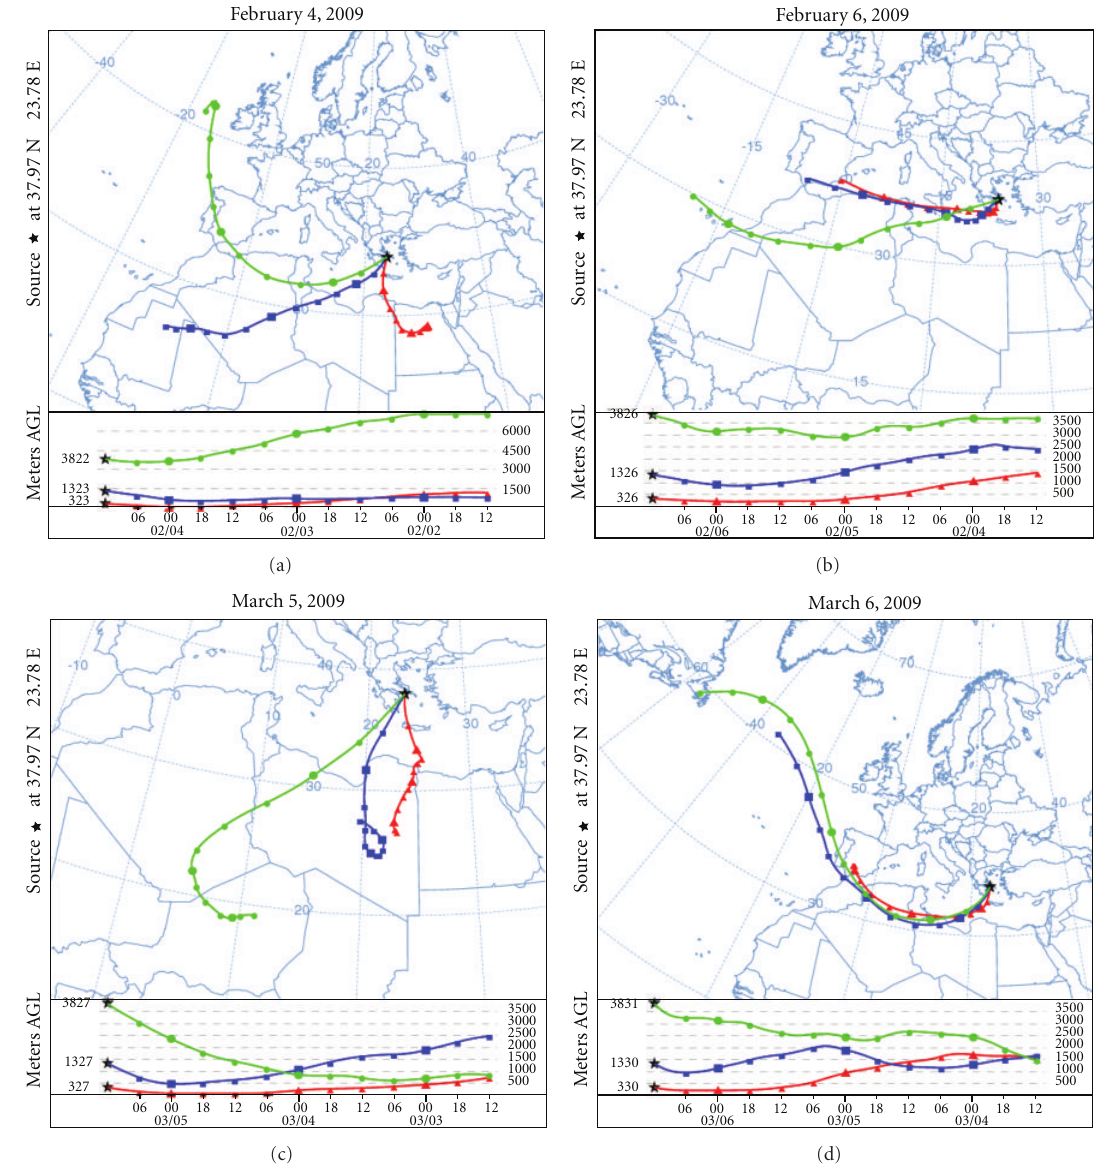
Figure 3: Air mass back trajectories at 4000m, 1500 m, and 500m for February 4, 2009 (a), February 6, 2009 (b), March 5, 2009 (c), and March 6, 2009